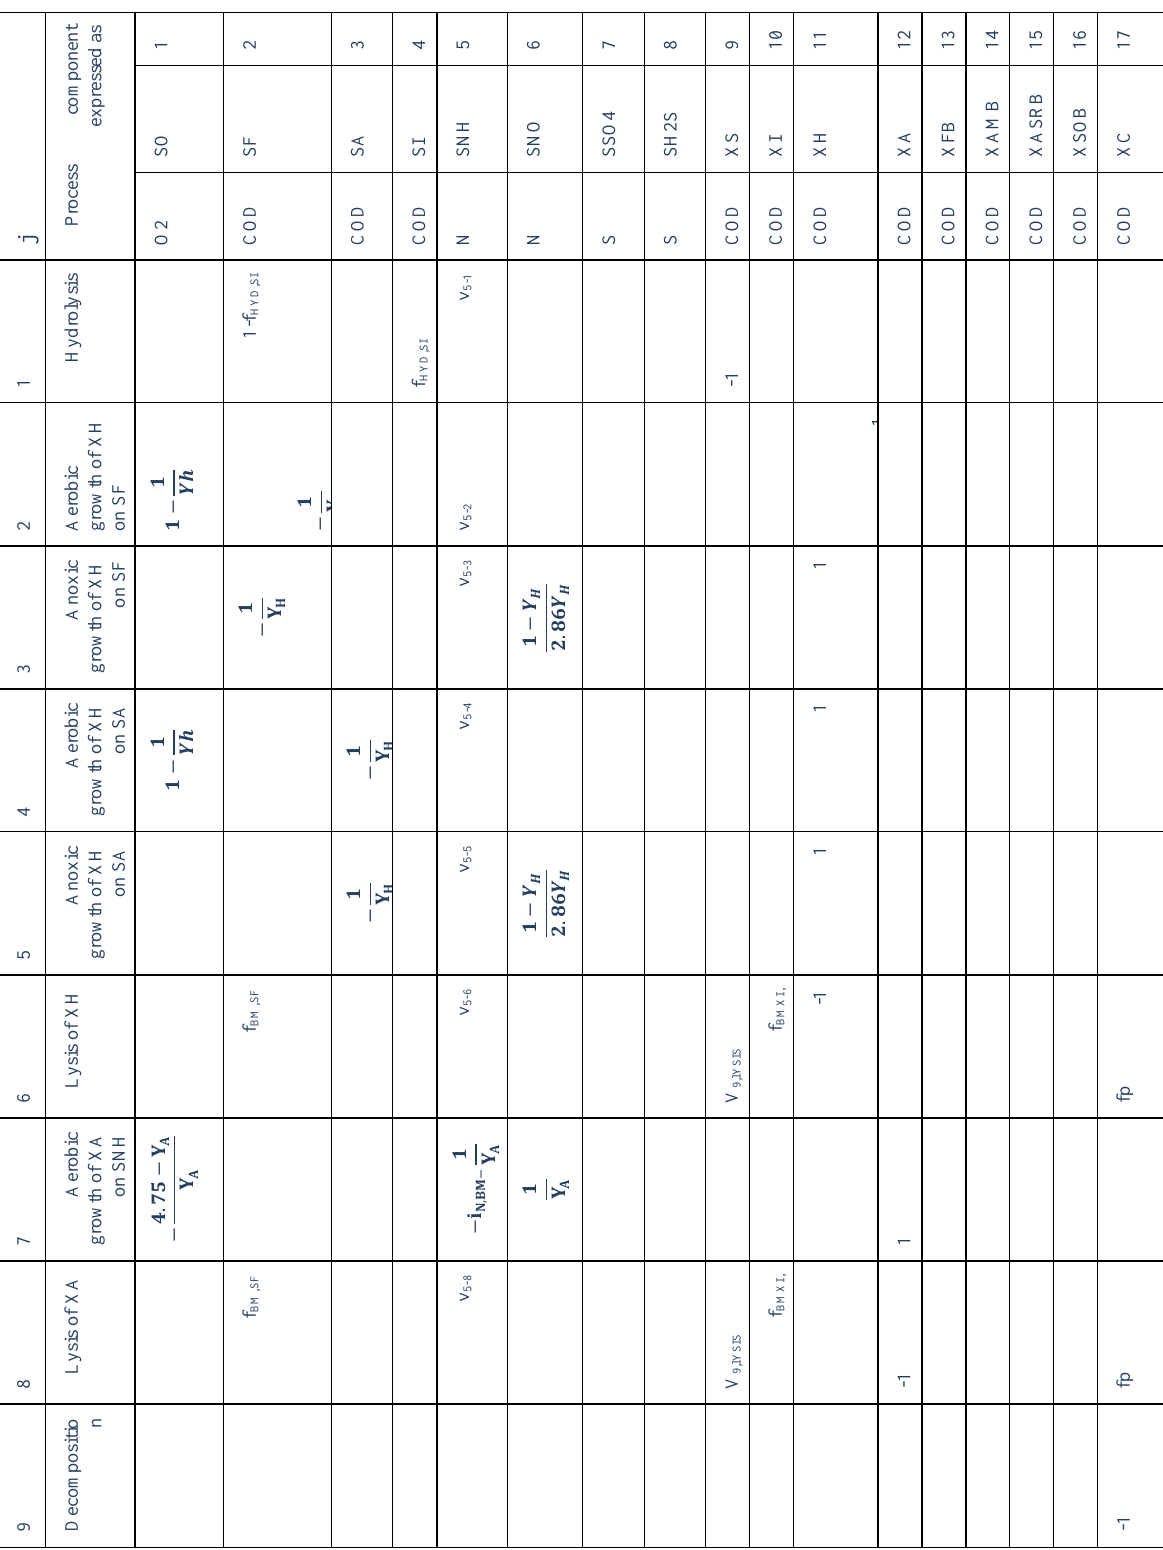
Table 1. Kinetic and schoichiometry matrix of CWM1